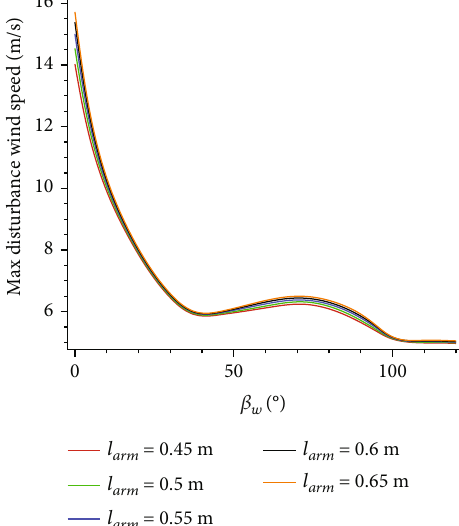
Figure 38: In fl uence of the l arm on the wind disturbance rejection performance.